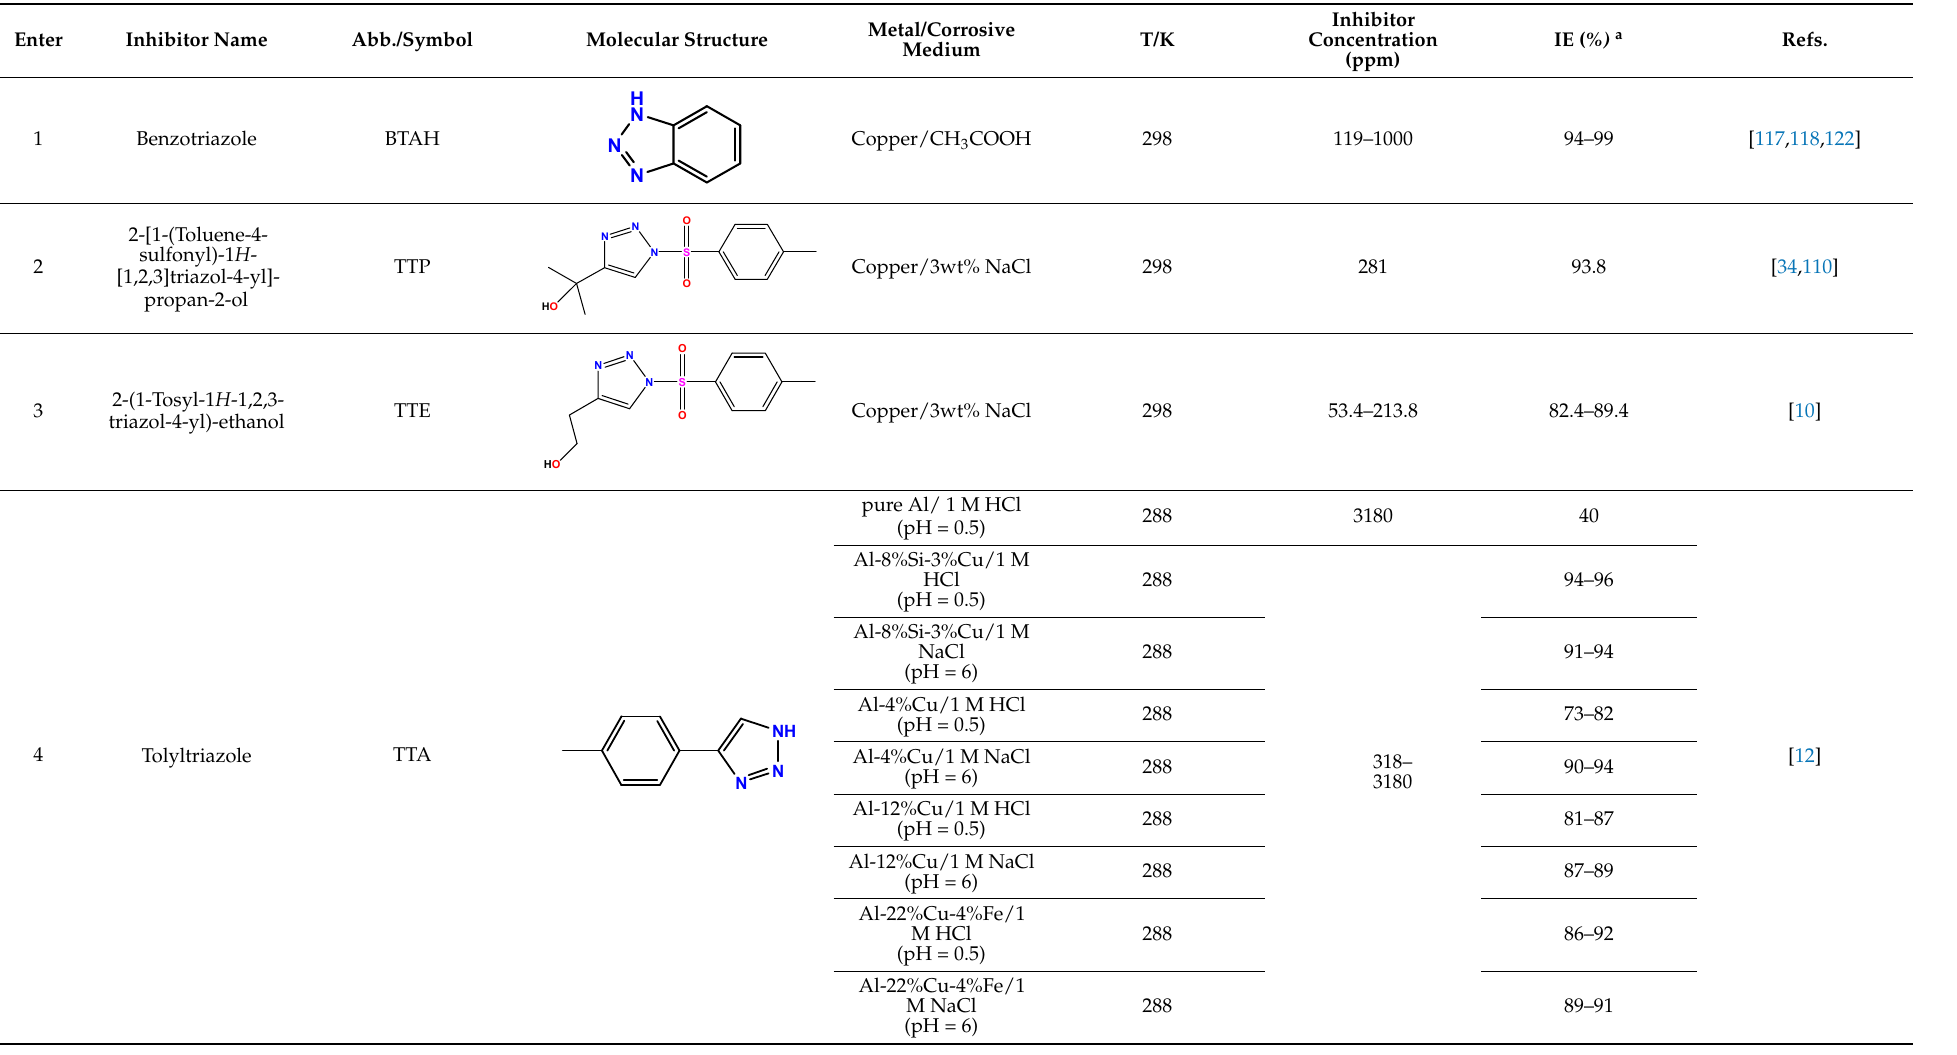
Table 2. Set of 1,2,3-triazole derivatives as corrosion inhibitors for copper, aluminum, and their alloys.